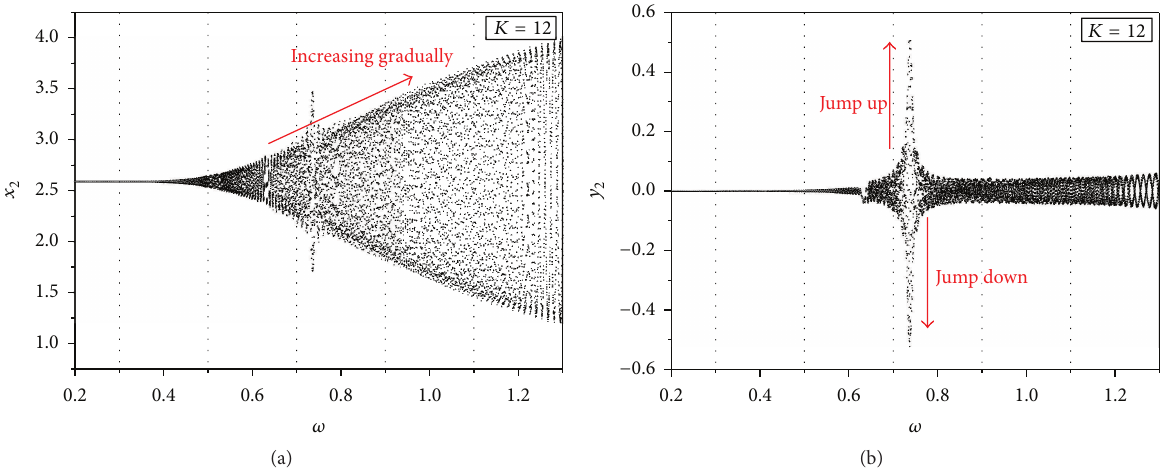
Figure 18: The steady-state response of displacement when 𝑛 = 30 : (a) 𝑥 2 and (b) 𝑦 2